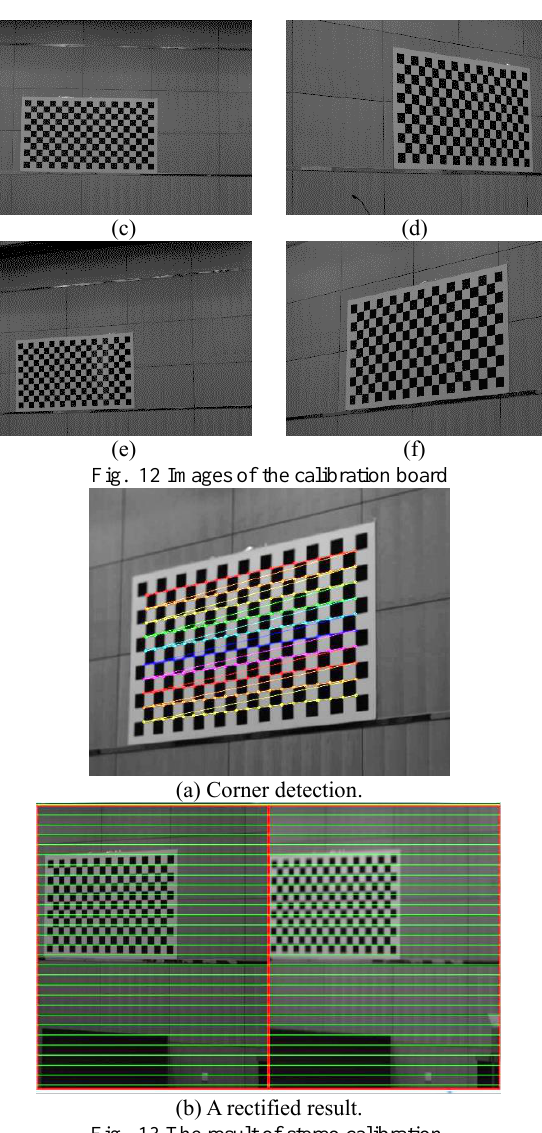
Fig. 13 The result of stereo